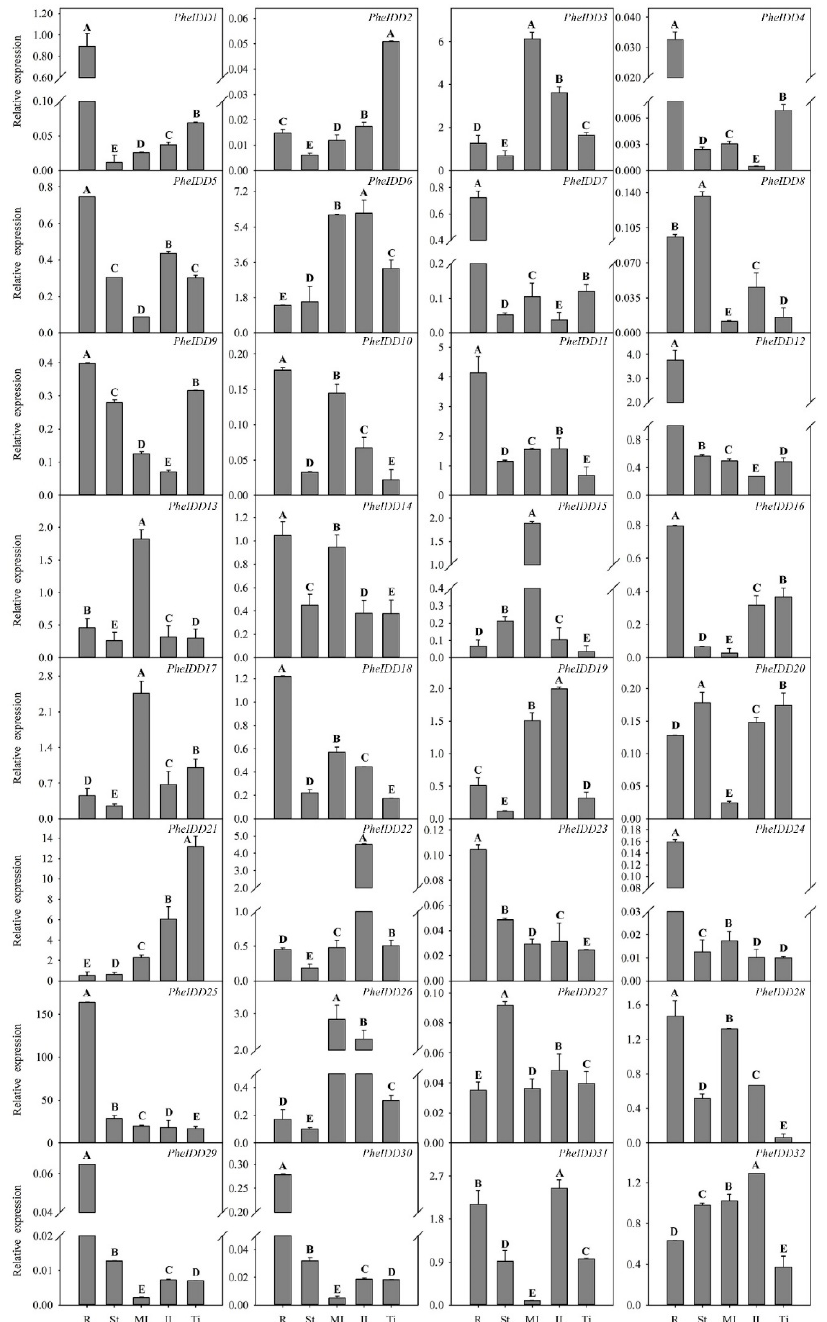
Figure 5. Tissue-specific expression patterns of PheIDD family genes in different tissues of moso bamboo. R: root, St: stem, Ml: mature leaf, Il: immature leaf, Ti: tiller. The PheNTB gene was used